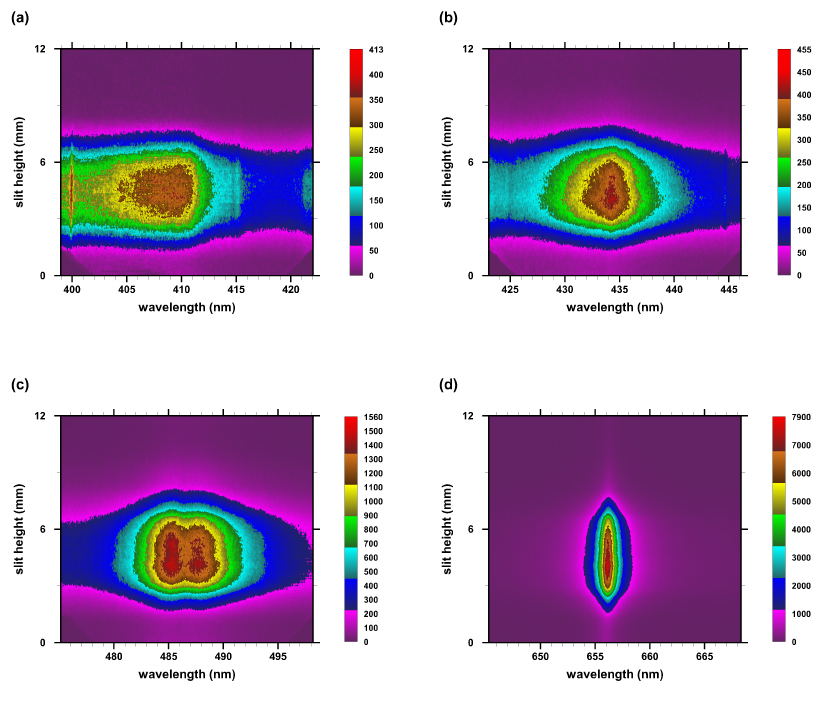
Figure 1. Recorded Balmer-series hydrogen lines at 0.75- µ s time delay, 0.025- µ s gate. ( a ) H δ , ( b ) H γ , ( c ) H β , and ( d ) H α .